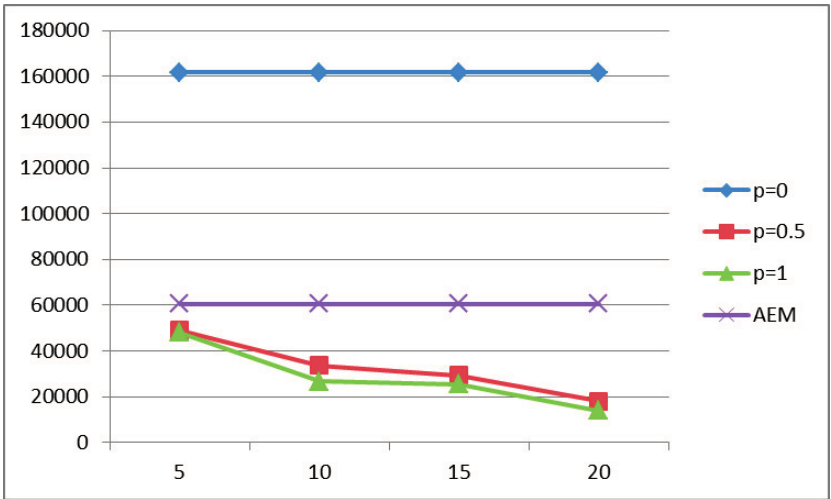
Figure 10. Energy